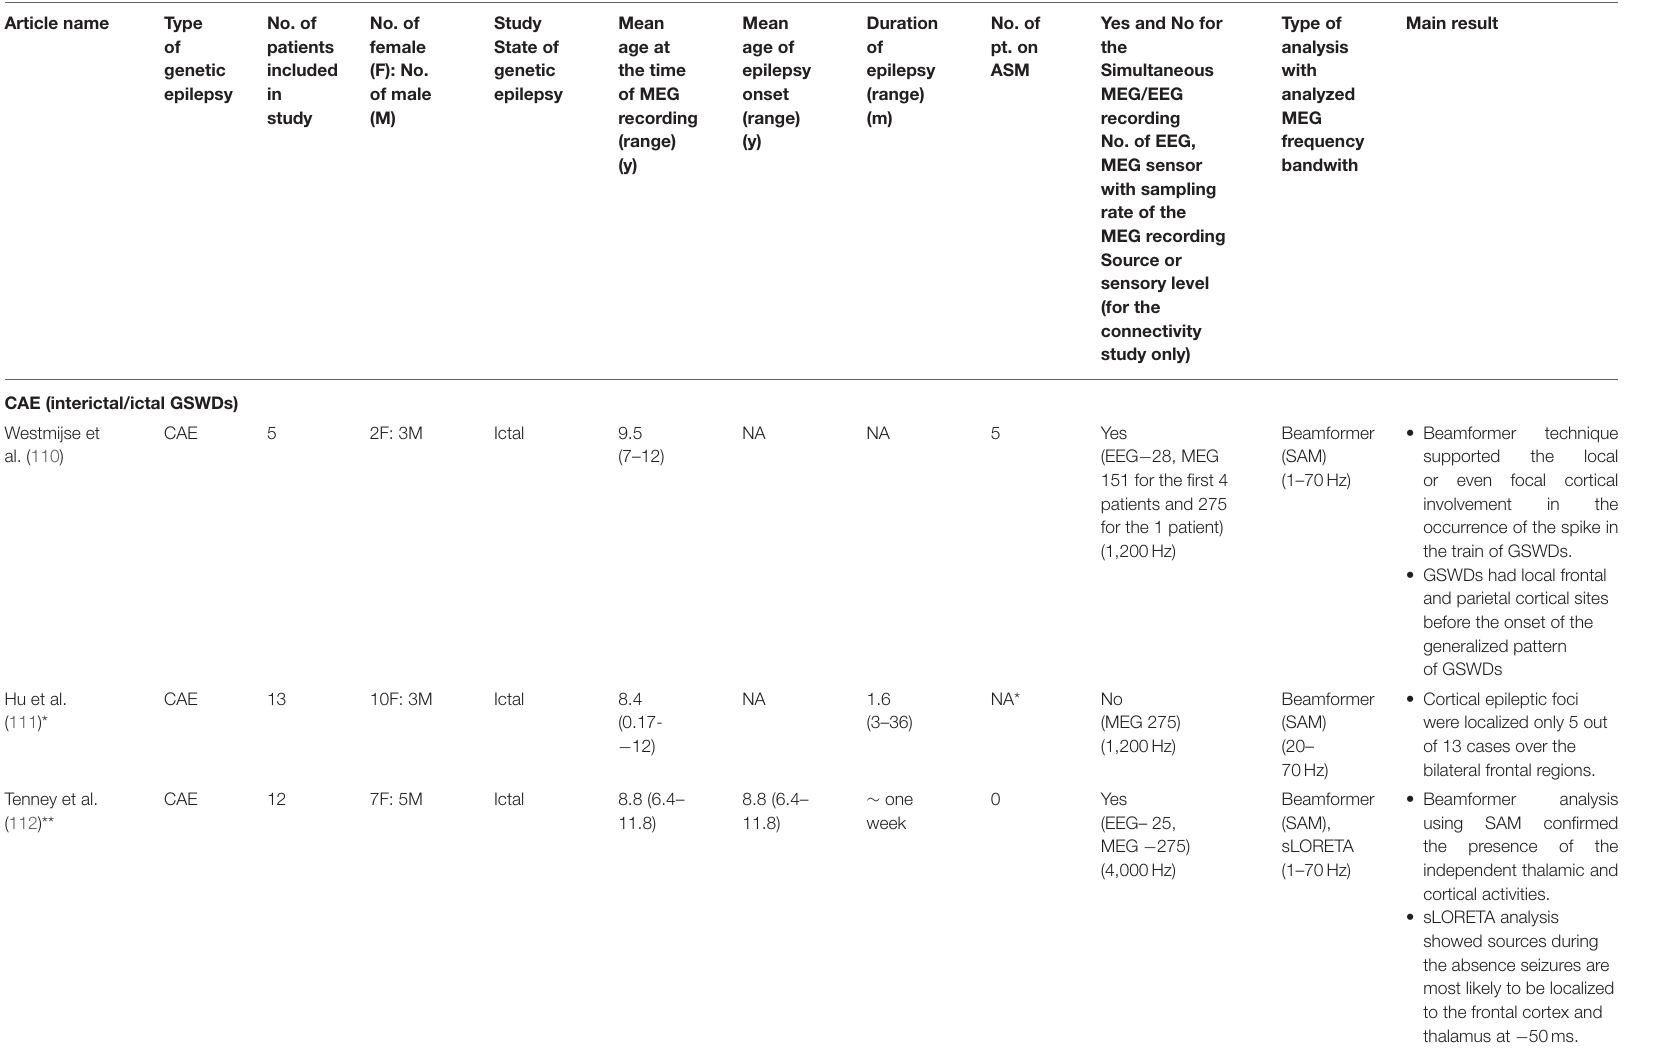
TABLE 1 | Showing all the published study characteristics and main outcomes on childhood absence